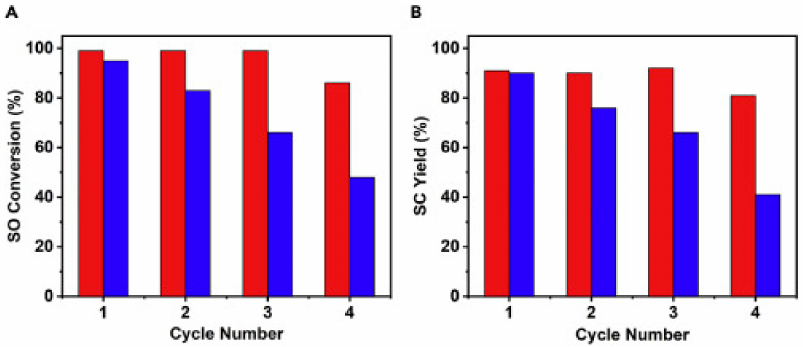
Figure 14. Catalytic performance of MIL-101 (blue) and MOF@mSiO 2 -YS (red) for cycloaddition reaction of SO with CO 2 : ( A ) SO conversion, ( B ) SC yield. Reprinted with permission from Ref. [159]. Copyright 2020 Elsevier.